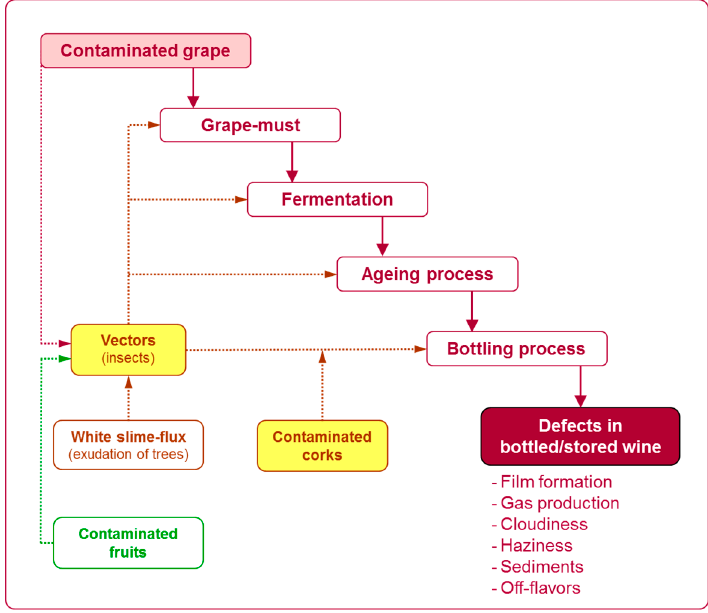
Figure 2. Main sources of Saccharomycodes ludwigii , as a spoilage yeast in wines.